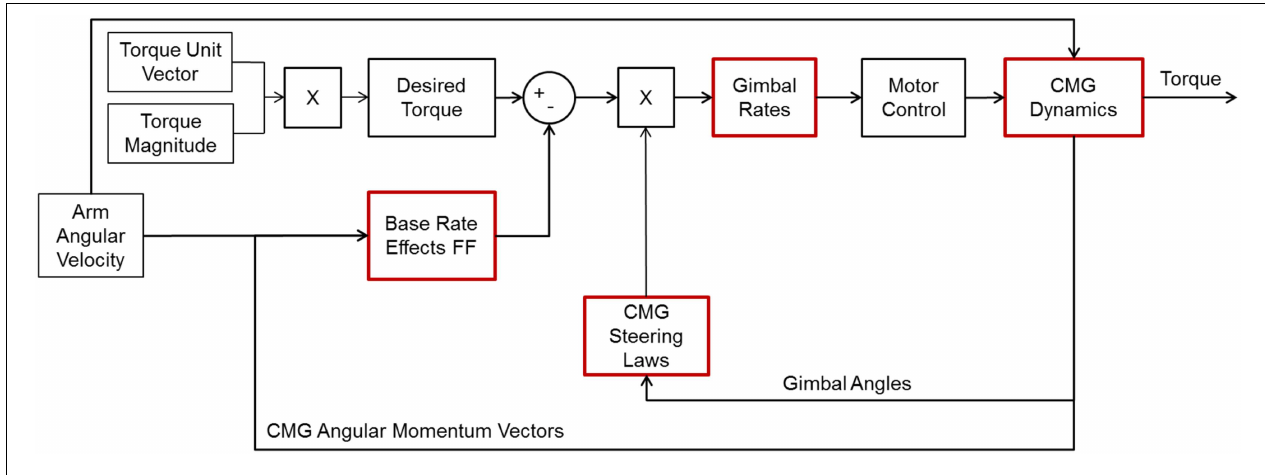
“down” tracking), the desired torque magnitude, and the angular velocity of the arm. The red boxes indicate aspects of the simulation that are unique to each array.